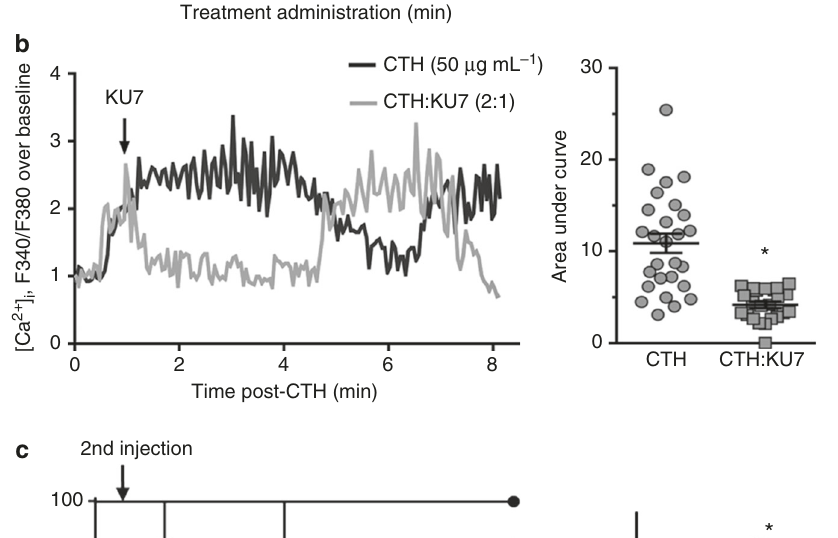
(DAPI) stain demonstrates the formation of extracellular NETs (Fig. 6a; top, left panel) displaying histones (Fig. 6a; top, right panel). As shown in Fig. 6a, aptamer KU7 binds to human neutrophil-derived NETs (Fig. 6a, bottom, right panel). White color areas in the merged images demonstrate the close approx- imation of the aptamer KU7 with NETs (Fig. 6a; bottom, right panel). Importantly, anti-histone aptamer KU7 also attenuated NET-induced cell death (Fig. 6b), con fi rming their potential as a viable therapeutic option for clinical conditions (e.g., sepsis)